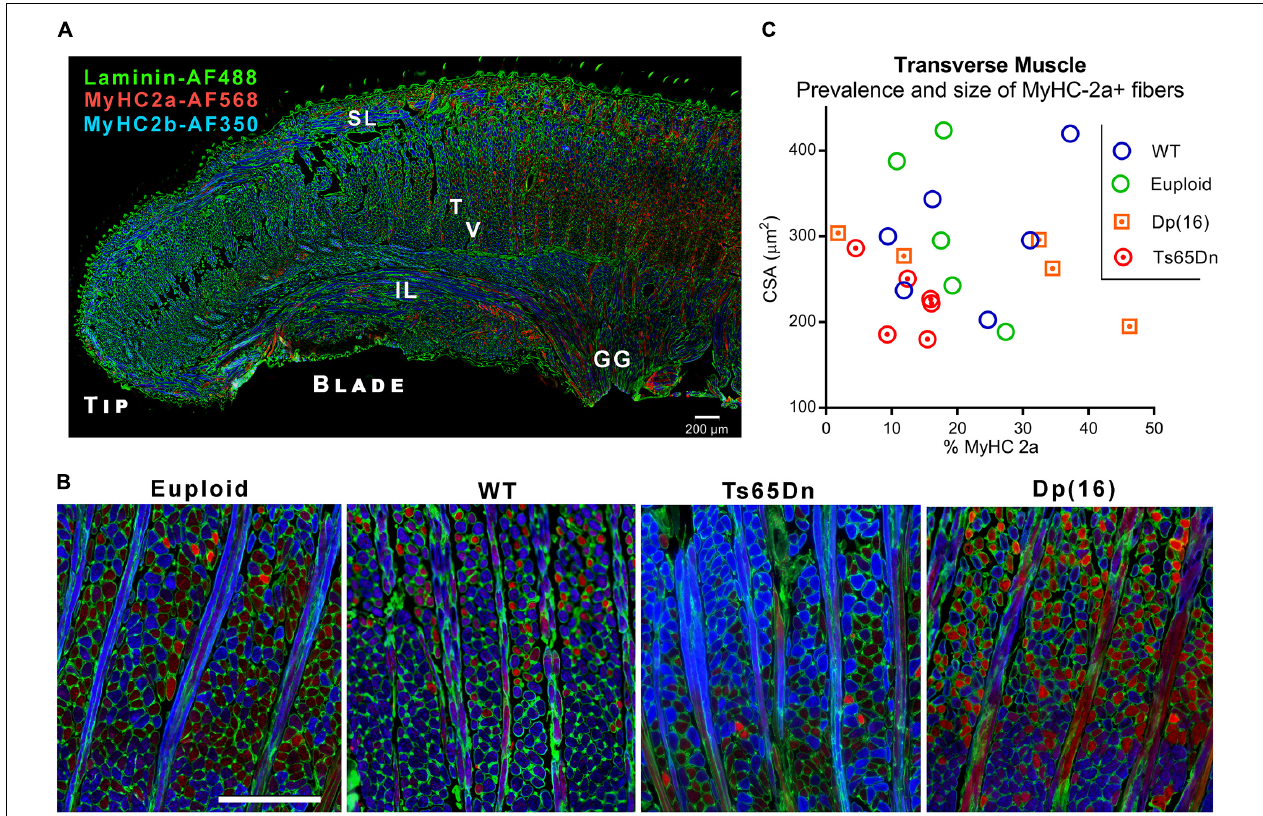
FIGURE 3 | Microscopy analysis of intrinsic tongue. (A) Longitudinal section of the intrinsic tongue of an euploid mouse. Note the broad transition from MyHC 2b to MyHC 2a extending from the anterior tongue to the posterior tongue. SL, Superior longitudinal muscle; IL, Inferior longitudinal muscle; T, Transverse muscle; V, Verticalis muscle; GG, Genioglossus muscle. (B) Transverse muscle fibers (in cross section) and verticalis muscle fibers (in longitudinal section) photographed in the blade of the tongue of adult mice. Blue staining indicates myofibers positive for MyHC 2b, and red staining indicates myofibers positive for MyHC 2a. (C) Quantitative analysis myofiber cross-sectional area (CSA) and the percentage of fibers positive for the MyHC 2a isoform. Each symbol indicates values from one adult